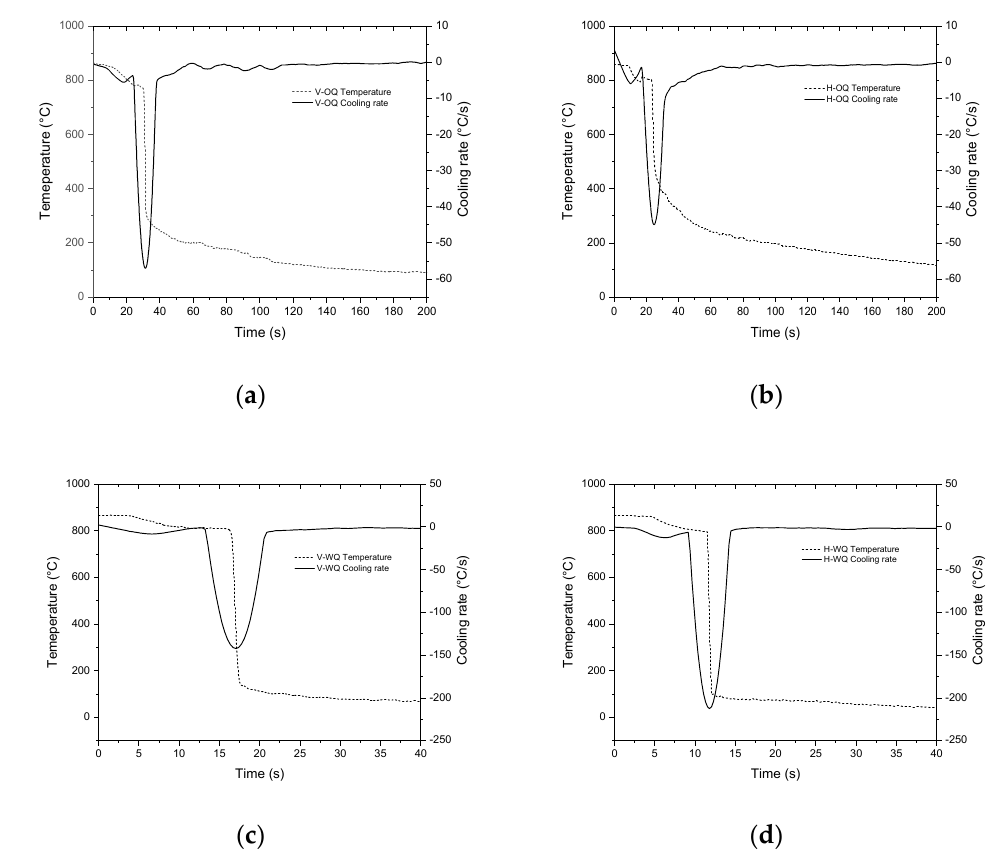
Figure 5. Maximum cooling rates in quenched AISI 4340 steel samples: ( a ) V-OQ; ( b ) H-OQ; ( c ) V-WQ; and ( d ) H-WQ.